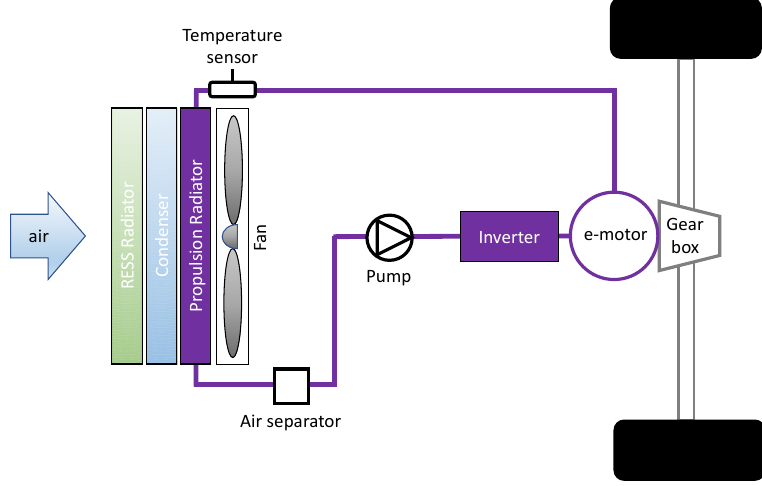
Figure 2. Single e-motor propulsion system and cooling system.